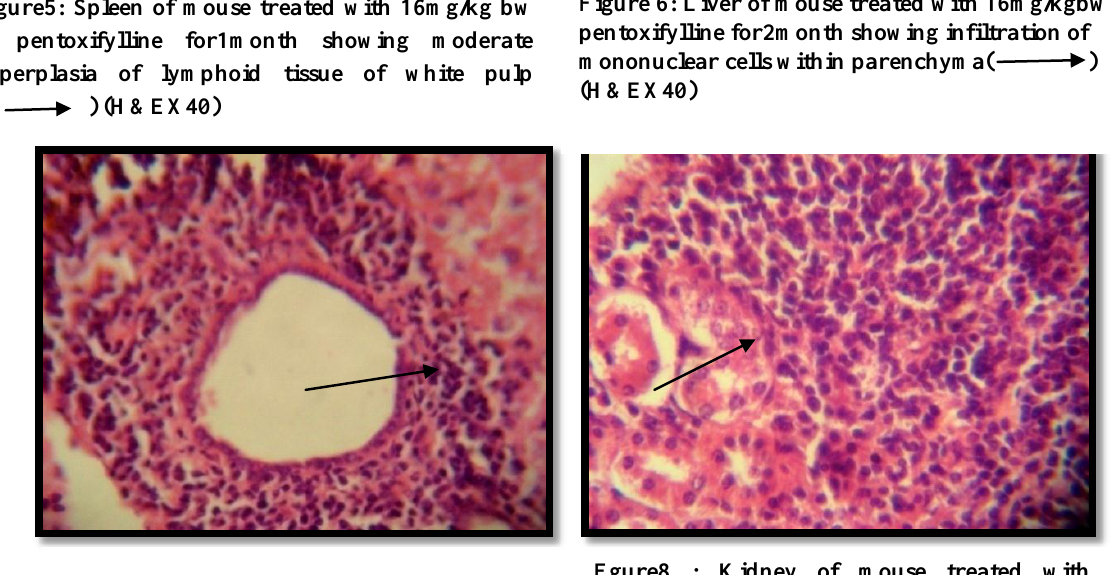
Fgure8 : Kidney of mouse treated with 16mg/kg bw of pentoxifylline for 2month showing infiltration of mononuclear cell within the interstitial tissue and in periglomerular area( (